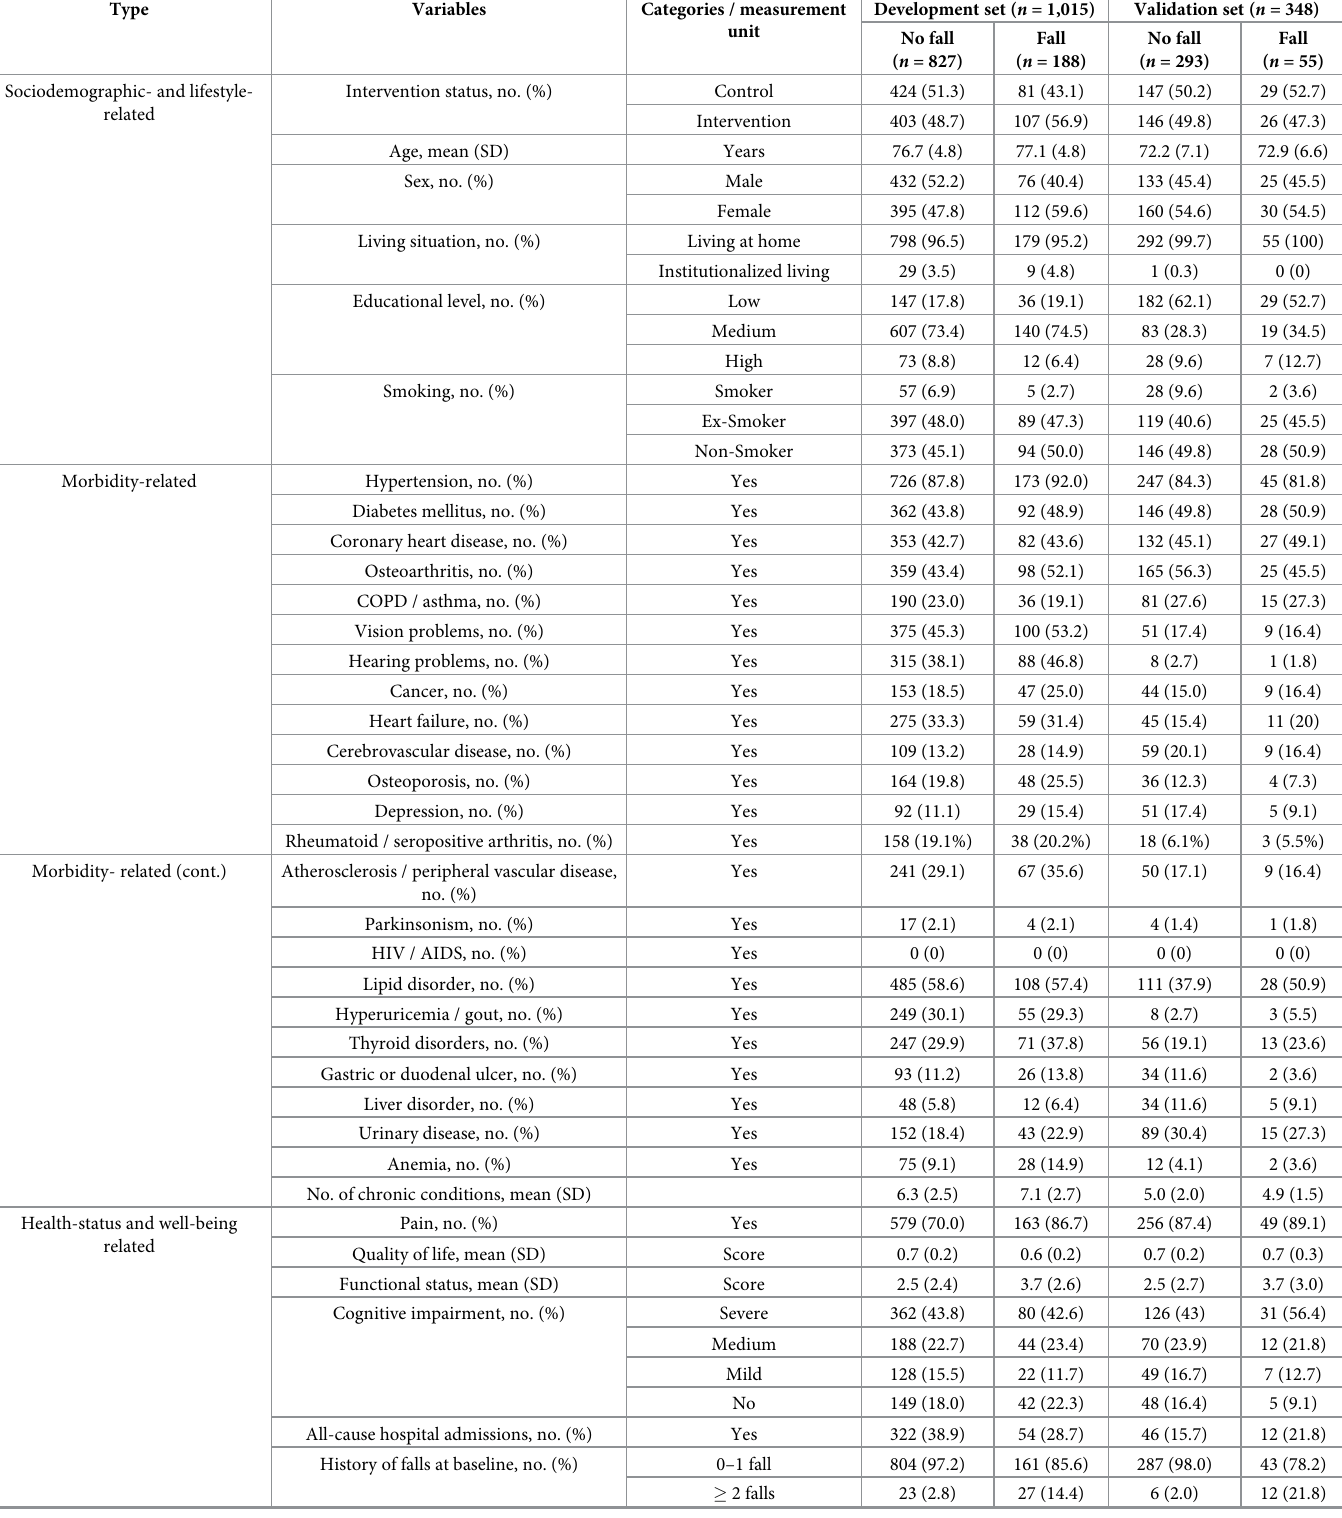
Table 1. Baseline characteristics of development and validation sets stratified per observed outcome (complete-case populations).